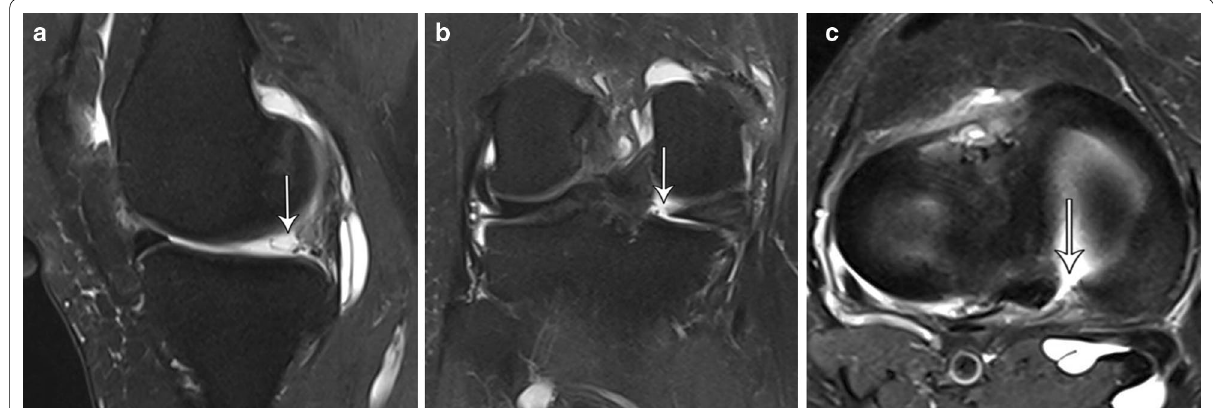
Fig. 20 Sagittal ( a ), coronal ( b ) and axial ( c ) T2‑weighetd fat‑suppressed MR images show “ghost sign” on posterior medial meniscal root attachment (thin arrows). Full‑thickness tear of the posterior medial meniscus root is clearly demonstrated in ( b ) and ( c